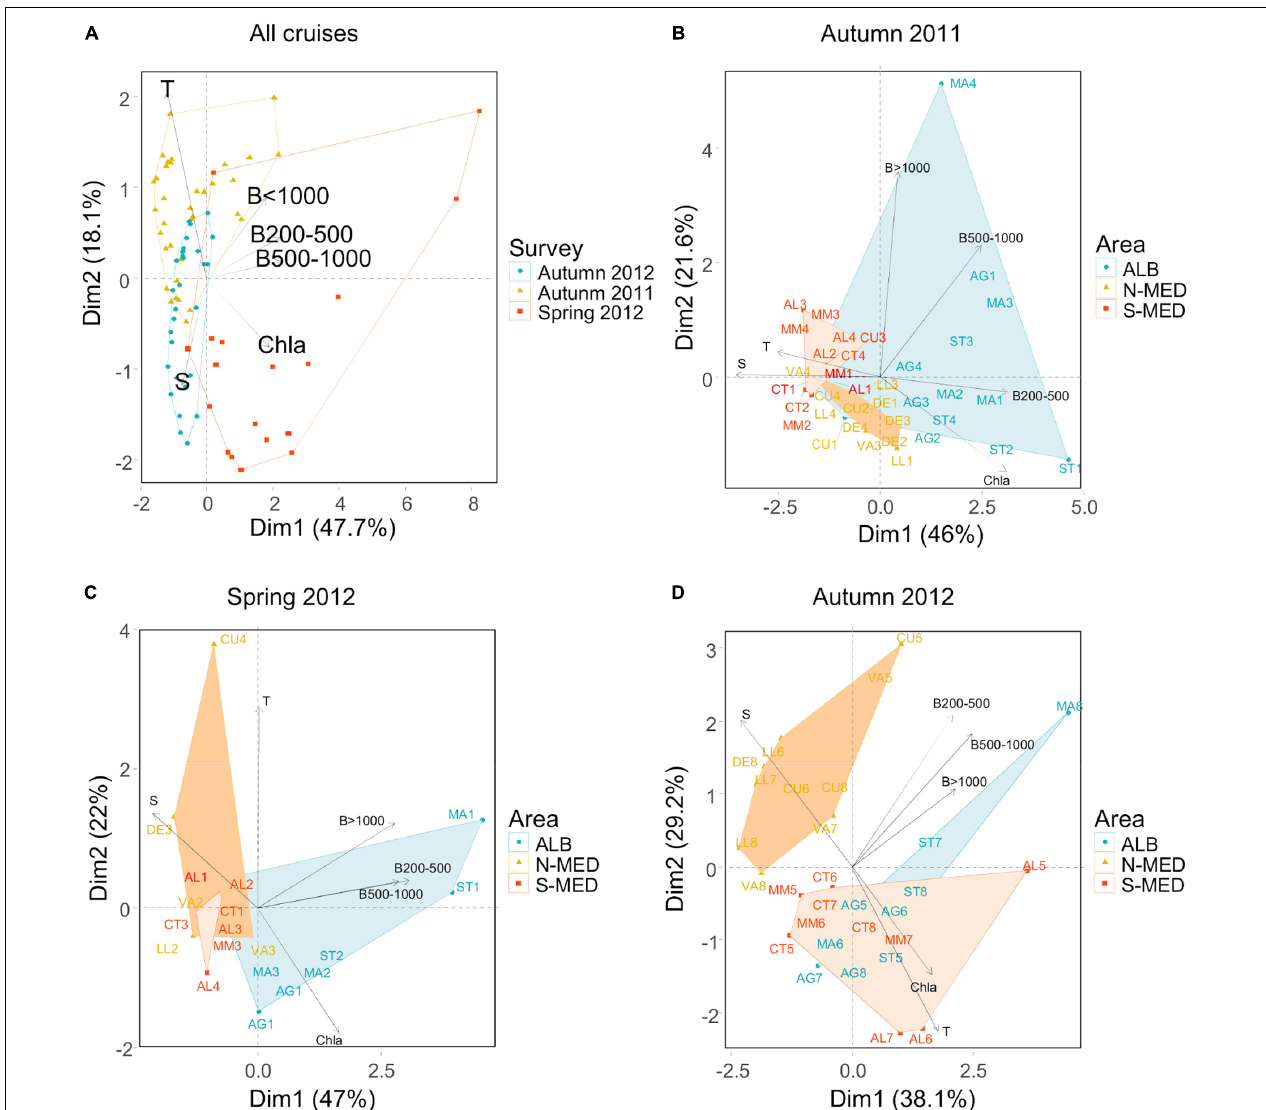
FIGURE 9 | Scores biplot for the environmental variables (temperature, salinity, chlorophyll a , and zooplankton biomass) and samples of the two first principal components (PC1 and PC2) obtained with the PCAs performed for (A) the overall pool of samples (all cruises), (B) autumn 2011, (C) spring 2012, and (D) autumn 2012. The total variance explained for each PC is shown as well as the clusters of samples obtained in ALB and the northern (N-MED) and southern parts (S-MED) of MED.